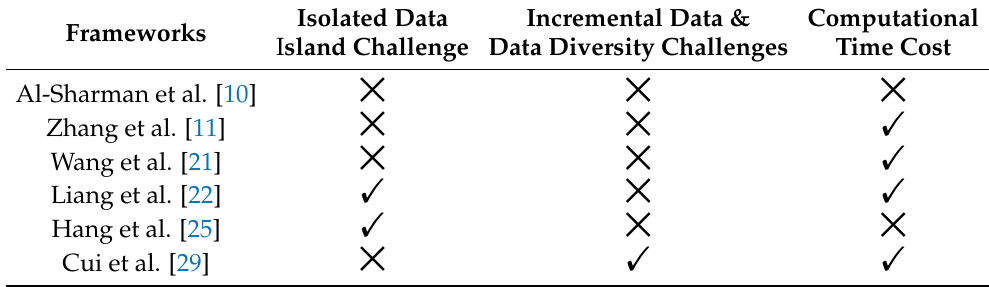
Table 1. Comparison of different